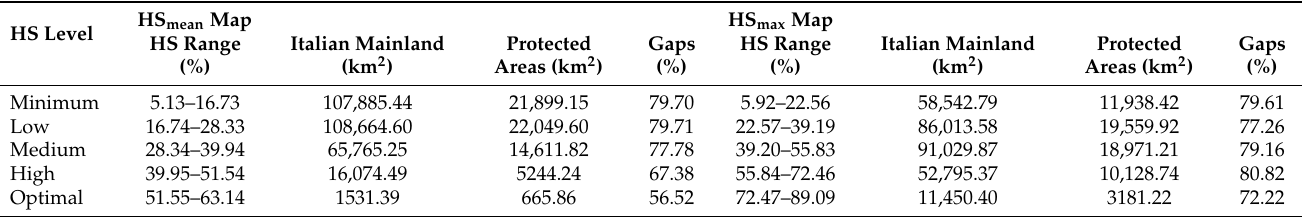
Table 3. Results of the raster layer unique value tool applied to the habitat suitability (HS) maps. The extent of the five HS levels was reported for the Italian mainland and for the protected areas (considering their maximum extent). The conservation gaps were reported as the percentage of non-protected areas for each HS level over the Italian